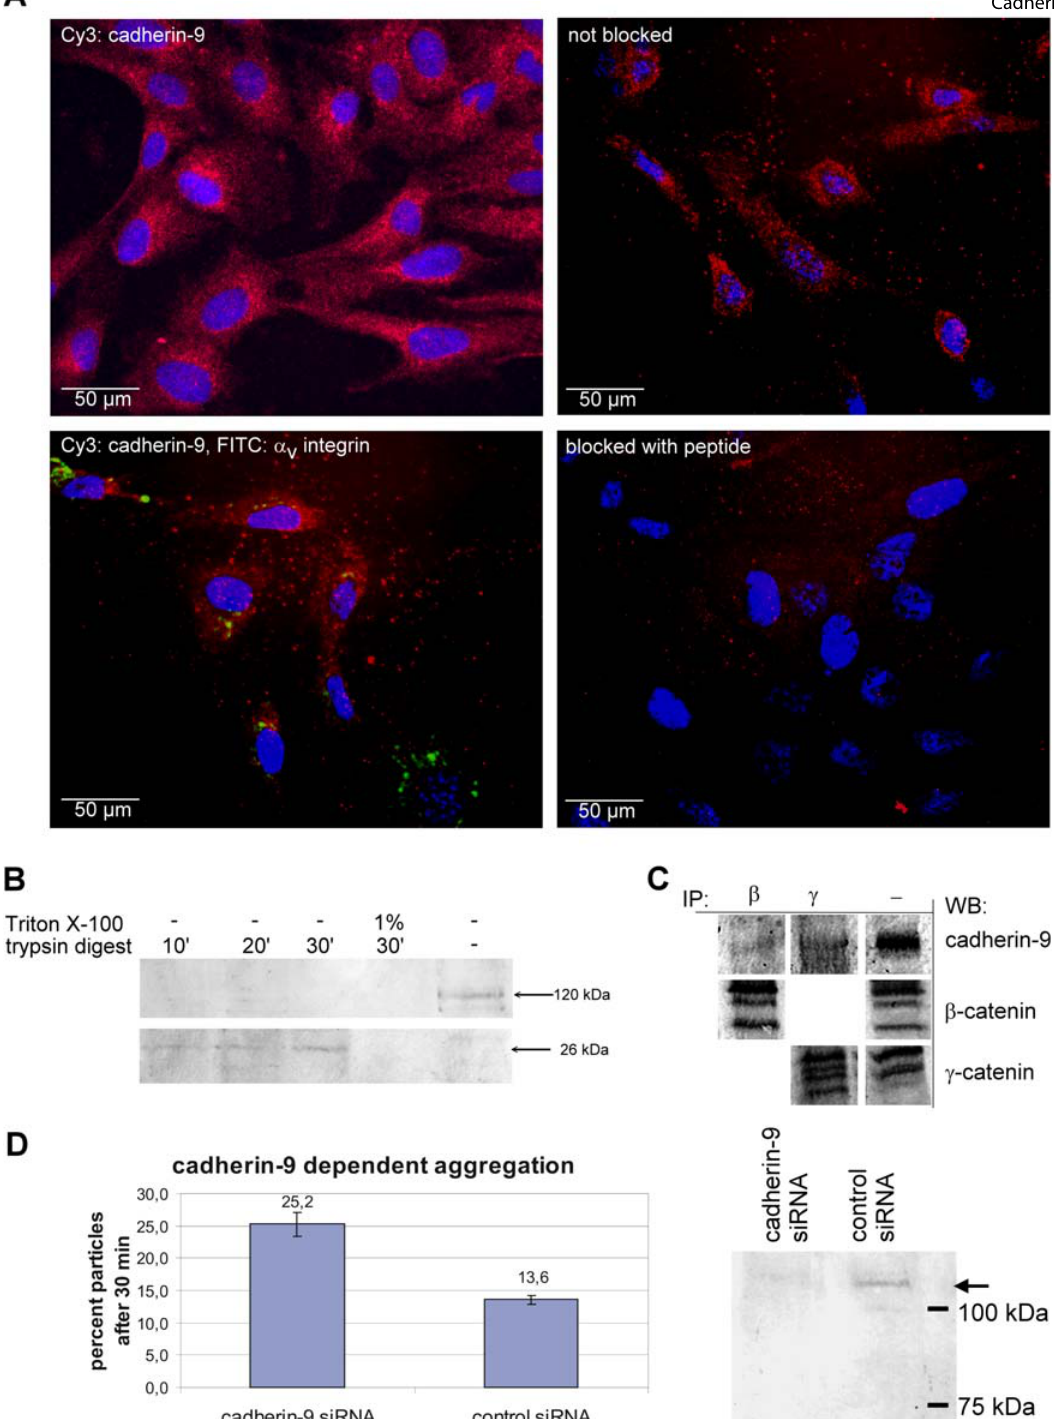
Figure 4. Cellular localization and functional involvement in fibroblast cell aggregation. (A) Immunofluorescence staining of cadherin-9 labeled the whole cell surface of TK 188 cells, and not, as initially expected, only cell-cell contacts. The specificity of the staining was shown by blocking with the antigenic peptide. In double staining experiments, the integrin a v -chain which marks focal adhesions showed no co-localization with cadherin-9. Bars, 50 m m. The pictures of the blocking experiment and the double-staining were gamma-corrected (B) To verify the expression on the cell surface, cellular cadherins were digested with trypsin in the presence of EDTA and subjected to Western blotting. After 10 minutes already, no full length cadherin-9 product was detectable, whereas a digestion fragment of approximately 26 kDa appeared. This fragment is most likely the C-terminal end containing the cytoplasmic tail, the transmembrane domain and a radically truncated extracellular domain. This fragment is protected from digestion in the absence of Triton X-100 and can be recognized by the antibody. In the presence of Triton X-100 no cadherin-9 signals were visible. The control cells which were not trypsin-treated showed the full length cadherin-9 product. (C) Co-immunoprecipitation experiments demonstrated the interaction of cadherin-9 with b - and c -catenin. The pictures of the different immunoblots were gamma-corrected. (D) Cadherin-9 was knocked-down in TK 188 cells by siRNA, and the efficiency of the down-regulation after two days of incubation was shown by Western blotting (on the right). The siRNA treated cells were used for an aggregation assay. The diagram summarizes the data collected in four independent experiments, each of them showing similar results. The capacity to form aggregates was significantly diminished (p , 0.00001) in cadherin-9 siRNA-treated cells, since these cells showed, after 30 minutes of aggregation, only 25.2% of their initial number of particles, whereas control siRNA-treated cells showed 13.6%. Error bars indicate the error of the mean. doi:10.1371/journal.pone.0000657.g004 PLoS ONE |